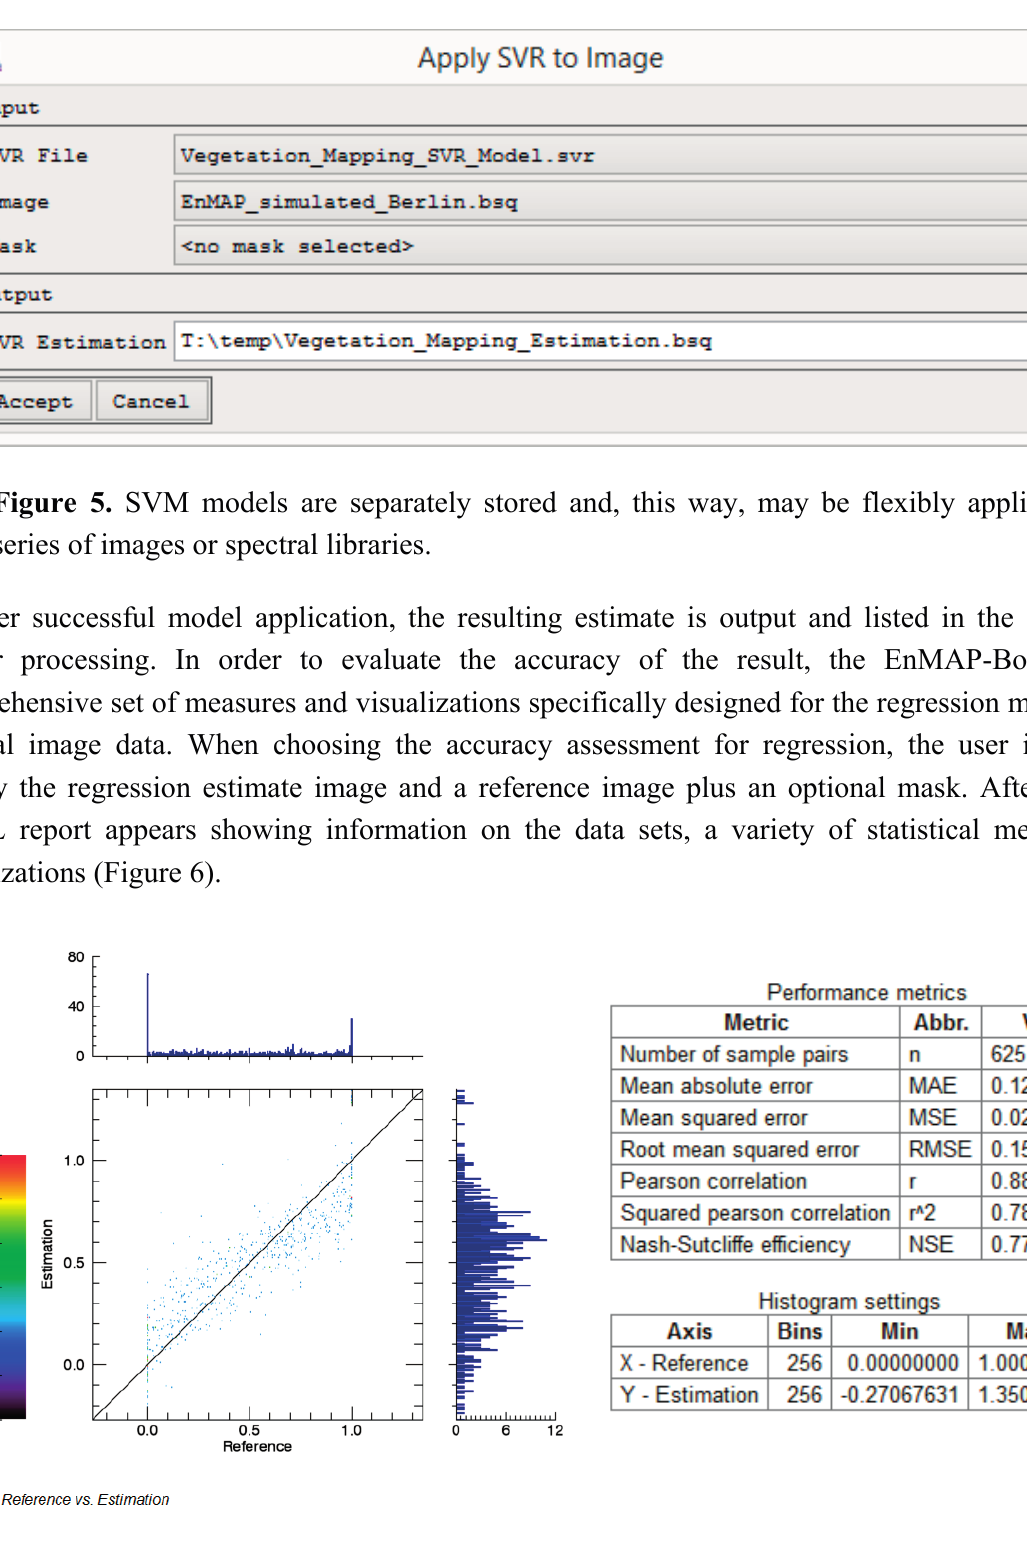
Figure 6. For comprehensive quantitative accuracy assessment the EnMAP-Box generates various statistical performance measures and visualizes histograms in an HTML report (figure shows excerpt